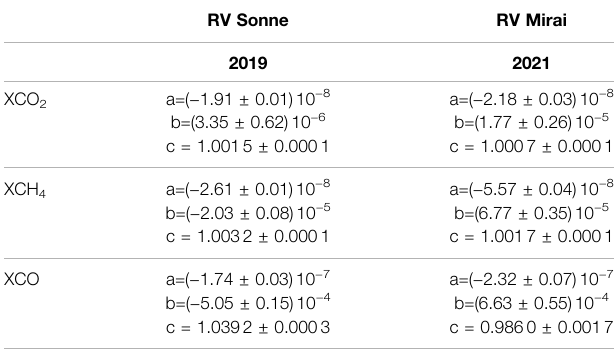
TABLE 2 | Correction factors a [1/ 3 ◦ ], b [1/ ° ], c for the airmass dependent correction. Errors are the standard deviations of the fi ts. RV Sonne RV Mirai